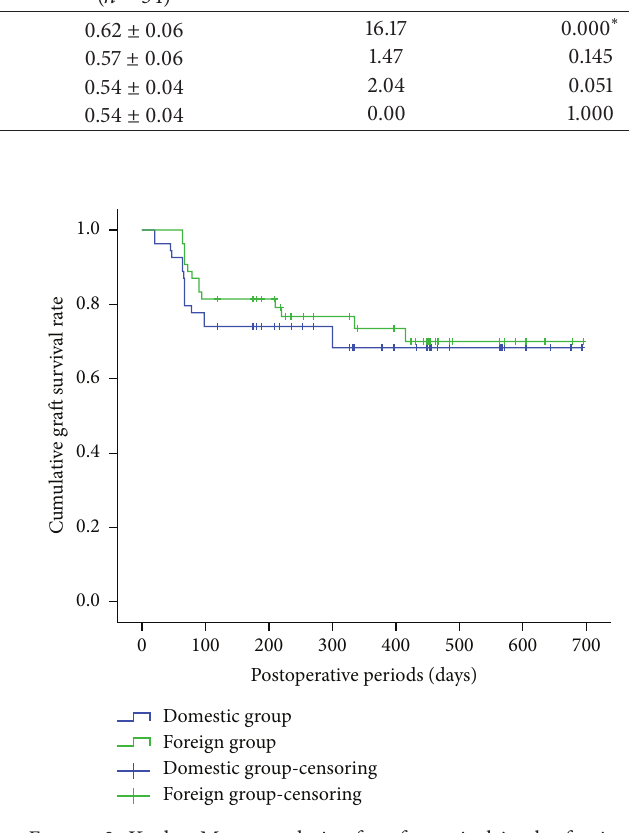
Figure 2: Kaplan-Meyer analysis of graft survival in the foreign (solid line) and domestic (dotted line) donor